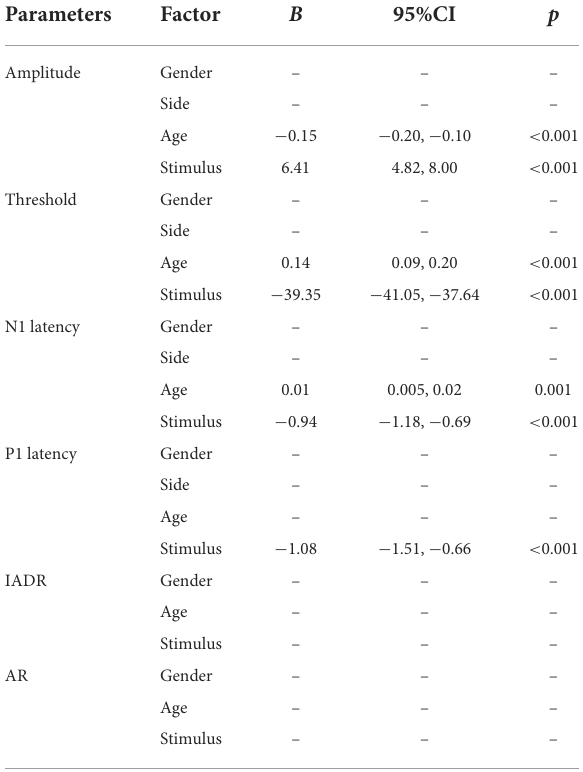
TABLE 5 Evaluating the effects of gender, age (continuous), stimulus, and side on oVEMP response parameters using multiple linear regression